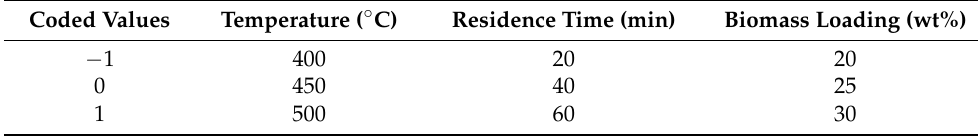
Table 1. Independent variables and their ranges used in Box–Behnken design .